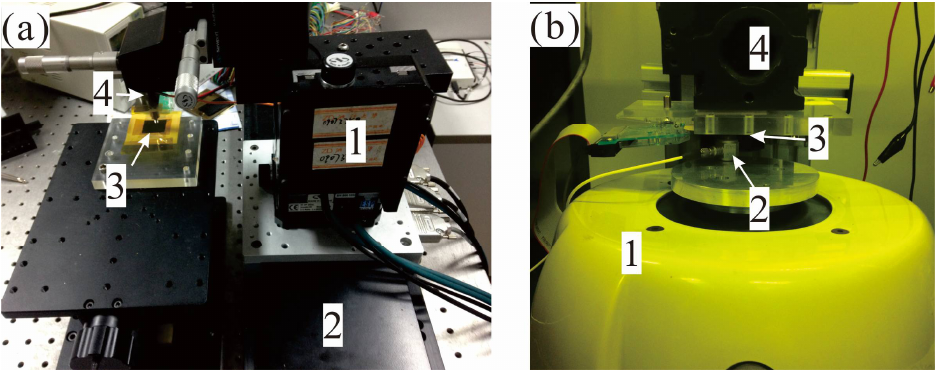
Figure 9. ( a ) A photo of static test equipment, where 1 is an auto positioner, 2 is a linear motion stage, 3 is proposed sensor and 4 is a static force sensor; ( b ) A photo of dynamic test equipment, where 1 is a vibration exciter, 2 is a dynamic force sensor, 3 is proposed sensor and 4 is manual positioner.